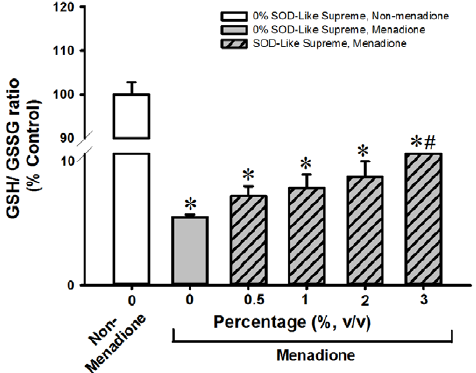
Figure 4. Effects of SOD-Like Supreme on cellular GSH/GSSG ratio in AML12 cells following menadione challenge. After the co-incubation of AML12 cells with SOD-Like Supreme and menadione, cellular GSH/GSSG ratios were measured, as described in Materials and Methods. The GSH/GSSG ratio of the non-menadione controls is 71.0 ± 2.0 (mean ± SD). Data are expressed as % of the non-menadione controls by normalizing relative to the value of the non-menadione-incubated cells. Values given are means ± SD, with n = 4. * Significantly different from the non-menadione controls; # Significantly different from menadione control group.